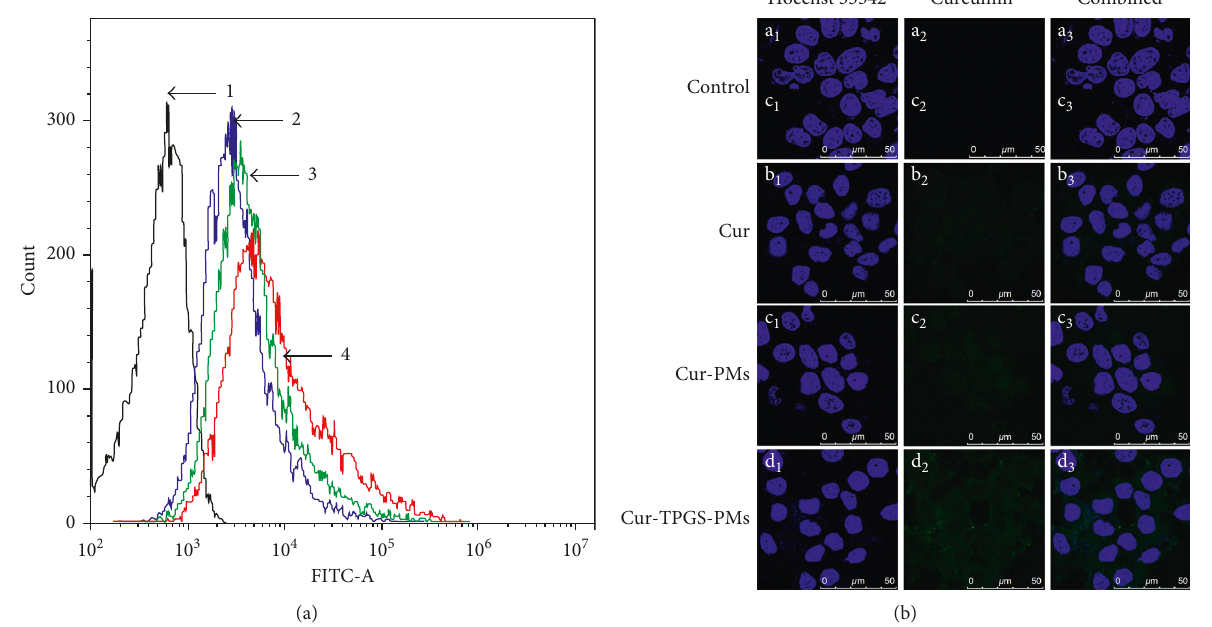
Figure 7: Intracellular uptake by MCF-7/Adr cells after treating with varying formulations by flow cytometry (a) and laser scanning confocal microscopy